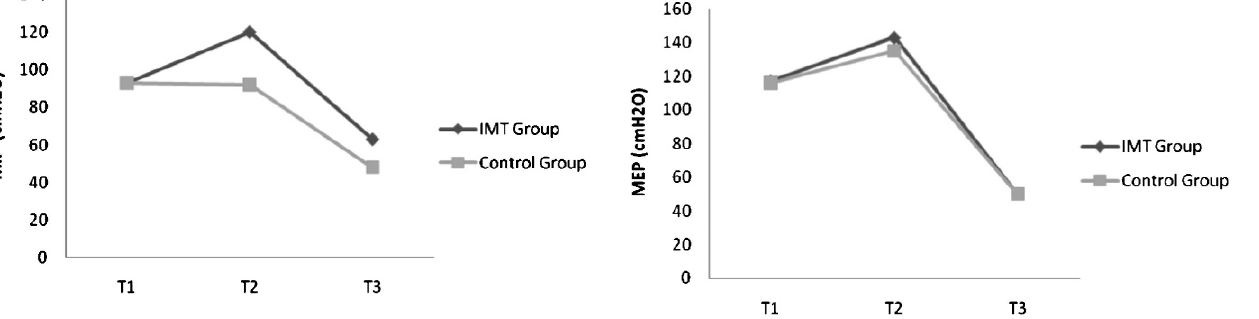
Figure 3 - MEP evaluations of T1, T2, and T3 in IMT (n=15) and Control (n=17) groups. (values expressed as